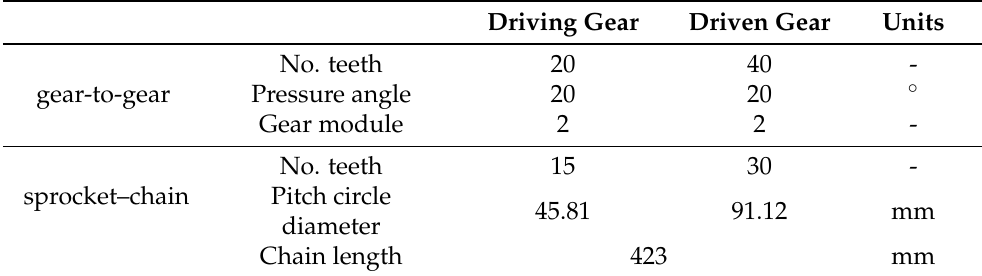
Figure 6. Sprocket–chain faults: ( a ) chain offset from the driving gear to the driven gear; ( b ) slightly worn damage at a tooth of the driven gear; ( c ) one missing tooth of the driven gear. Table 3. Gear-to-gear and sprocket–chain